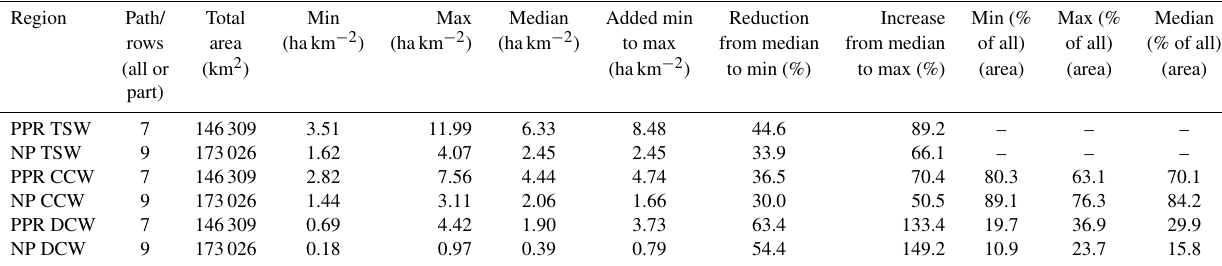
Table 6. Surface water extent conditions summarized for the Prairie Pothole Region (PPR) and adjacent Northern Prairie (NP). TSW – total surface water extent, CCW – continuously connected surface water that intersects the stream network, and DCW – disconnected surface water or surface water that does not directly intersect the stream network.